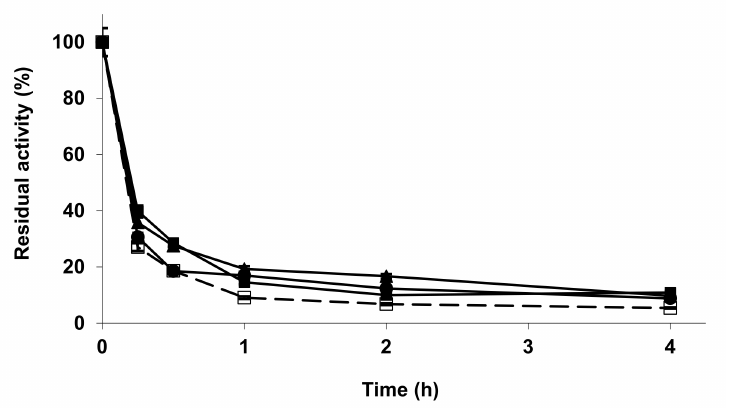
Figure 3. Inactivation courses of RM-IM unmodified and modified with metallic salt/sodium phosphate. The inactivation was performed with 10 mM Tris buffer at pH 7.0 and 60 ◦ C. Other specifications are described in the Methods section. Unmodified RM-IM (open squares and dotted line); RM-IM modified with ZnCl 2 /sodium phosphate (solid squares); CuCl 2 /sodium phosphate (solid circles); CoCl 2 /sodium phosphate (solid triangles).